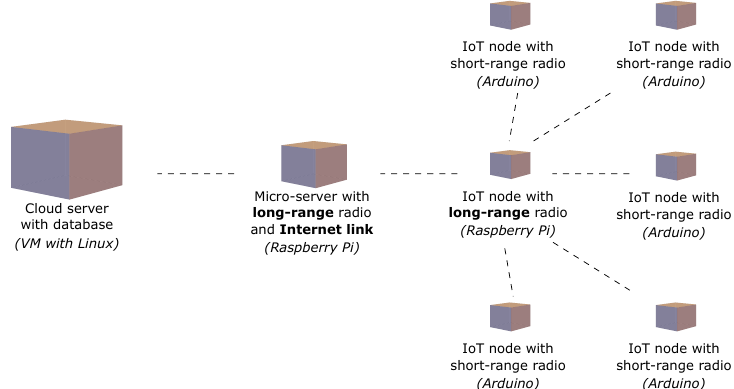
Figure 2. The architecture of our IoT system: Further Internet services connect to the cloud server, providing scientific modelling or lightweight applications to visualise